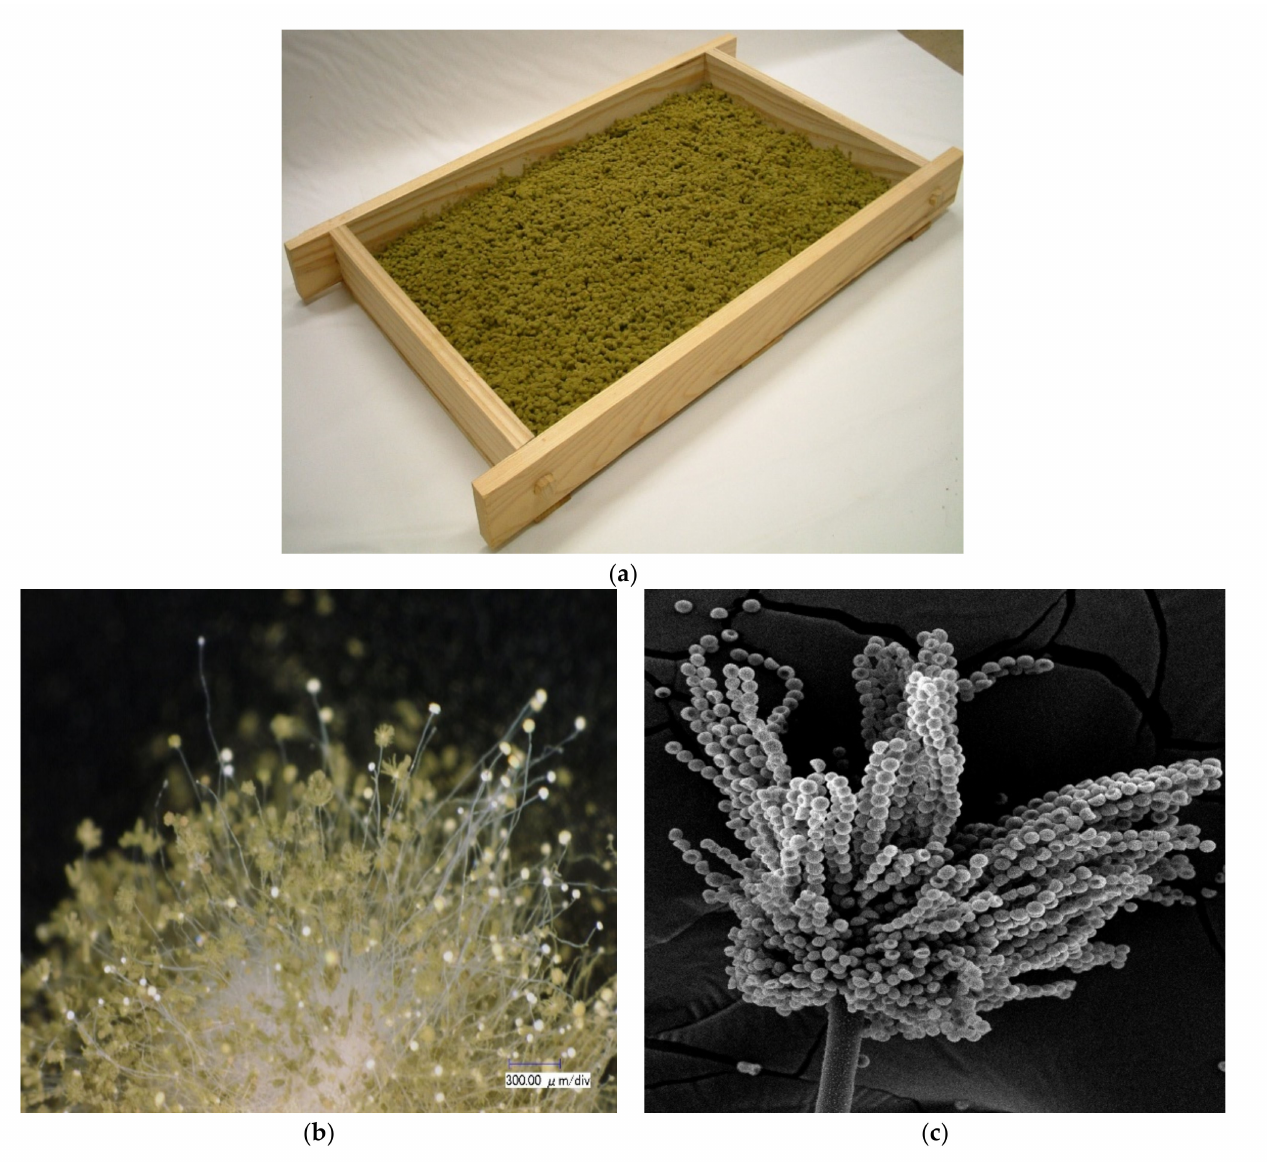
Figure 1. Koji starter and koji: ( a ) koji starter for sake produced by traditional method; ( b ) the appearance of koji mold ( × 400: photo is taken by SEM (Scanning Electron Microscope) TM3030Plus made by Hitachi High-technologies Corp.); ( c ) conidia formation of Aspergillus oryzae W-20 (96